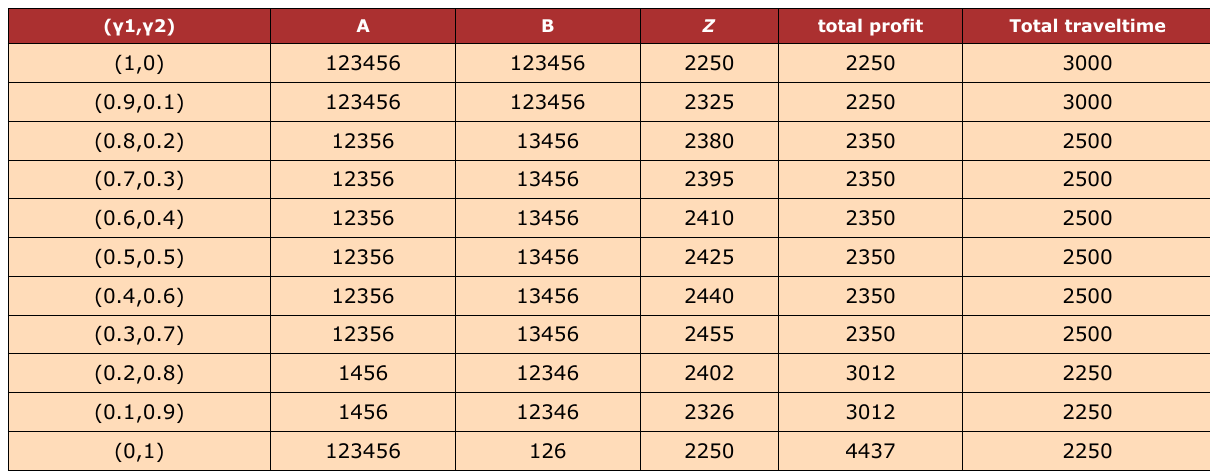
Table 2. Weight coefficient sensitivity analysis